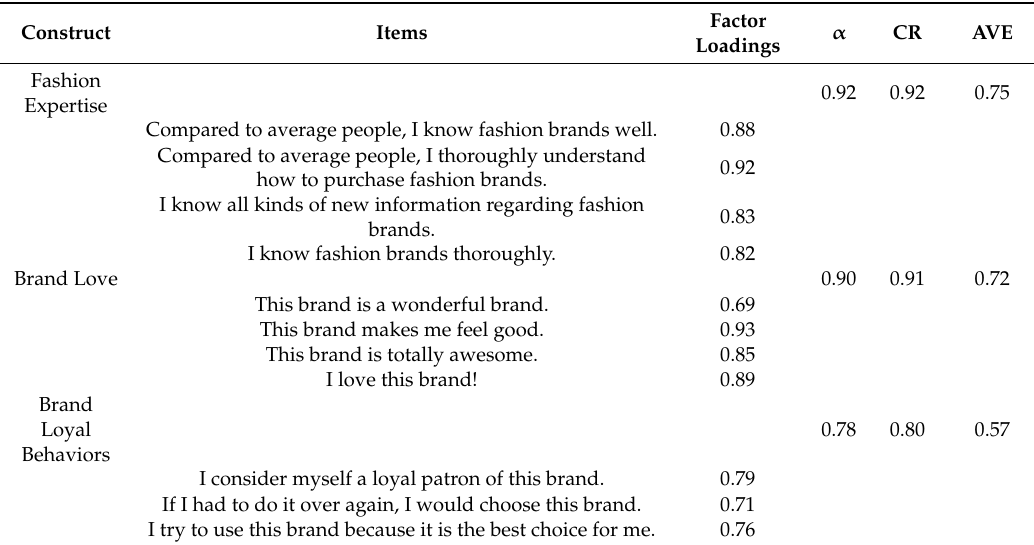
Table 2. Measurement model results.